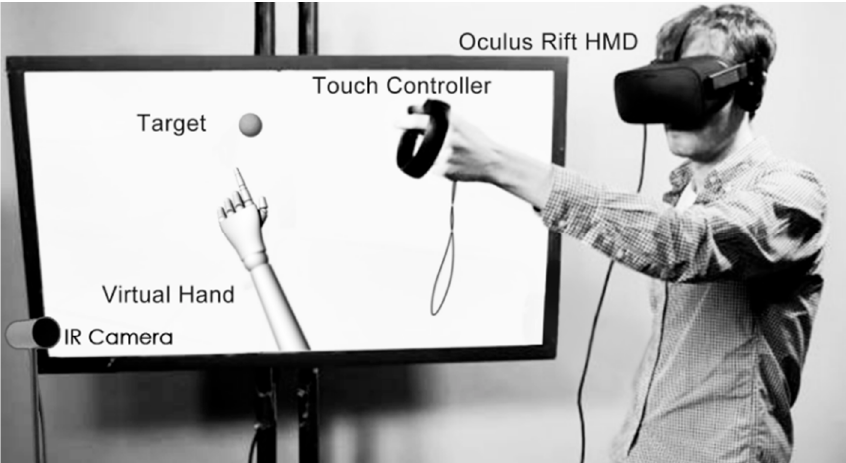
Figure 3. An illustration of the experimental setting and scenario: A male participant was acquiring a target through a handheld Oculus Touch controller. A flat screen configured beside the participant was used to present and monitor the task process.